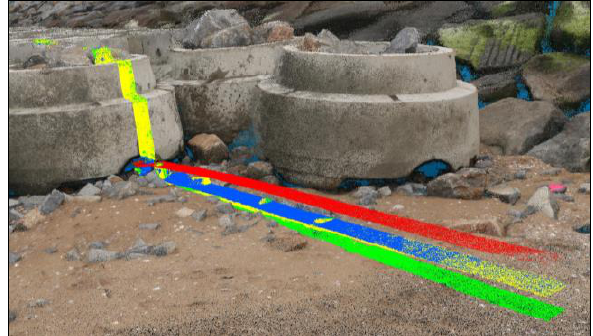
Figure 15 . Close view of the topographic variations for C2